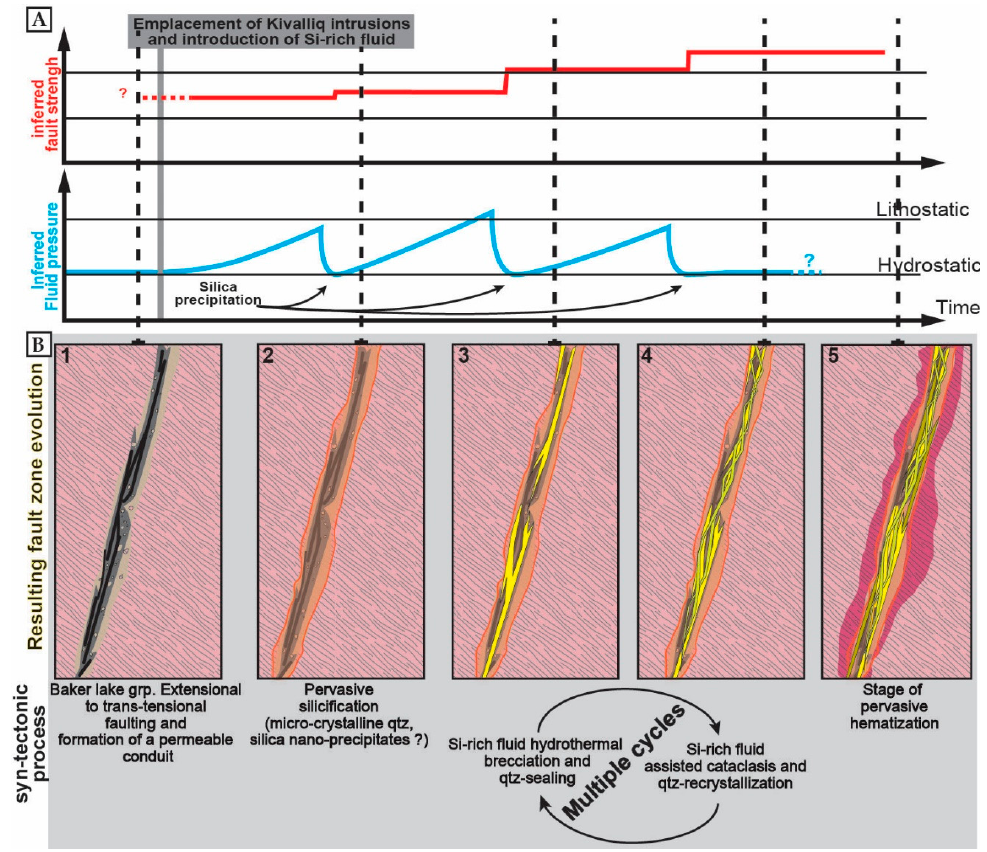
Figure 11. ( A ) Evolution of inferred fault strength (frictional shear resistance) and fluid pressure in the fault zone as a response of fluid pulse, fracturing and silica-precipitation. ( B ) Scheme depicting the succession of events that produced the QB.